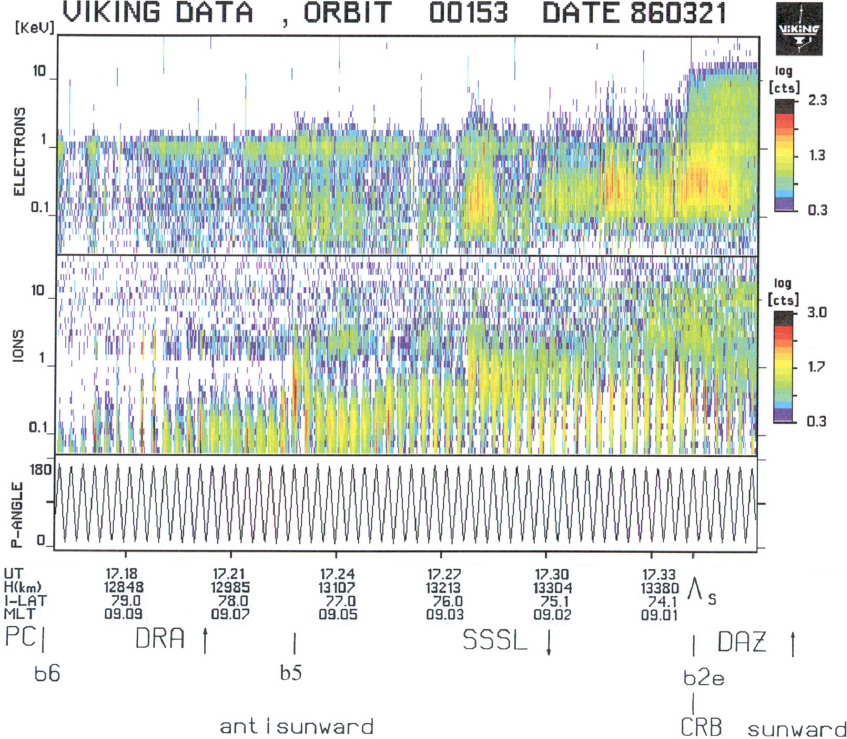
Fig. 12b. The same as Fig. 5b, except for orbit 153 on 21 March 1986, 1620–1736